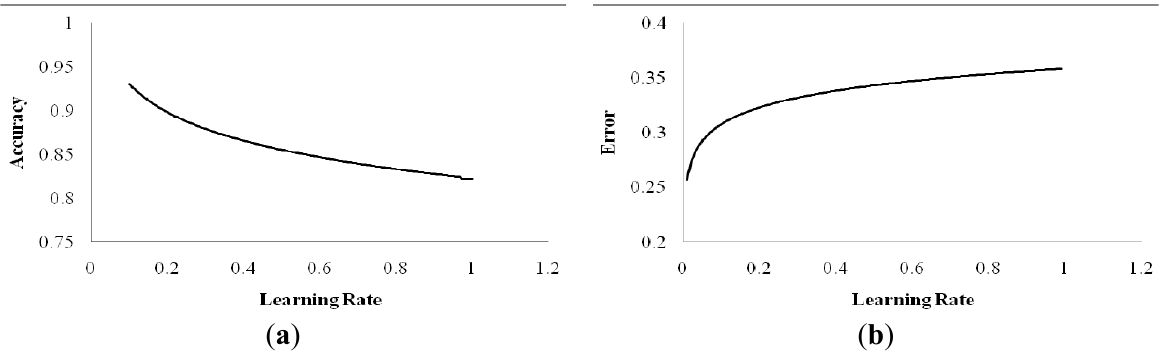
Figure 5. ( a ) Accuracy vs. Learning Rate. ( b ) Error vs. Learning